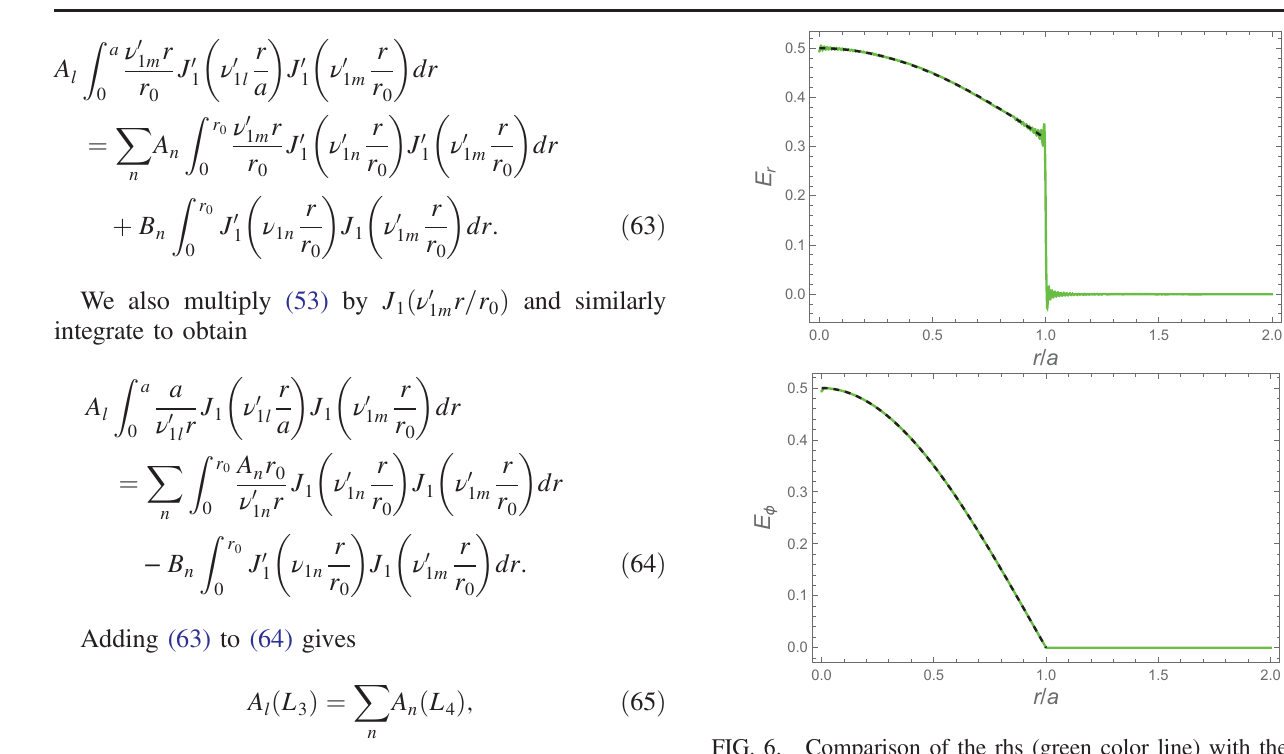
and Eq. (54) for E ϕ , with the r Þ ; B n n